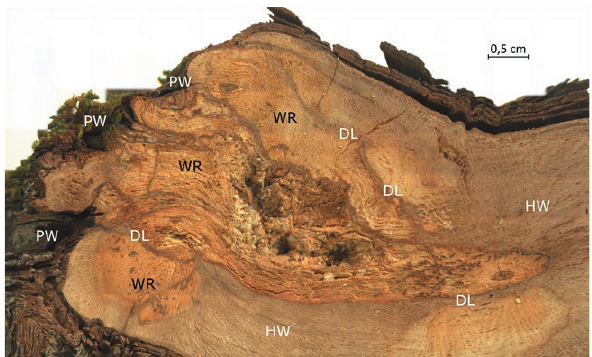
Figure 6. Macroscopic observation by stereo microscopy (×12 mag- nification) of a cross section (1 cm thick) of the head of a grapevine stem with a large area of white rot (WR) spreading from pruning wounds (PW) into healthy wood (HW). The necrotic zones are sep- arated from the healthy wood by demarcation lines (DL). Specimen collected in May 2021 from a 28-year-old ‘Sauvignon Blanc’ plant, from a vineyard in Pfaffenweiler, south-west